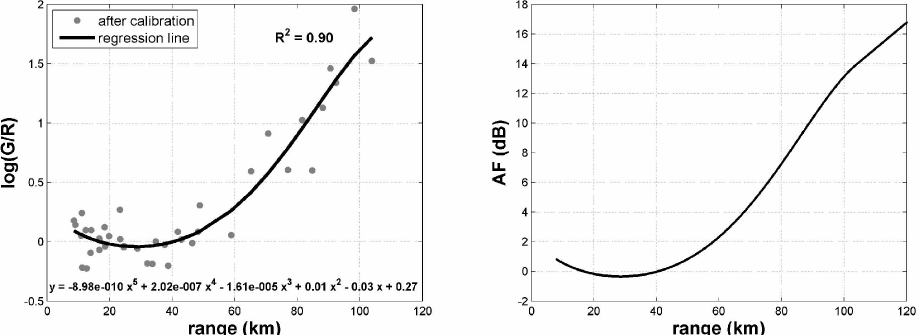
Fig. 5. Log( G/R) and adjustment factor (left and right panels, respectively) as a function of range resulting from observations at 1.5 ◦ elevations collected in